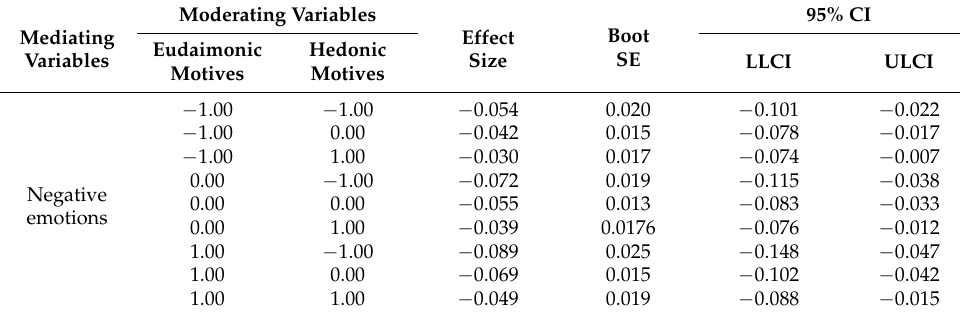
Table 4. The results of moderated mediating